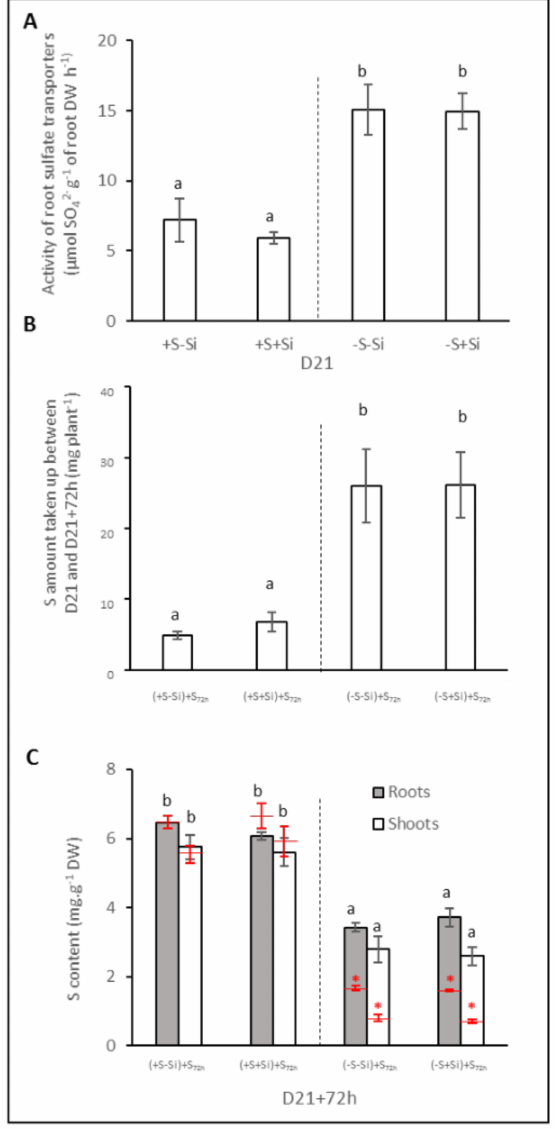
Figure 5. Activity of root sulfate transporters of Brassica napus L. at D21 ( A ), the S amount taken up between D21 and D21 + 72 h ( B ), and the S content in the root and shoot compartments of plants at D21 + 72 h ( C ). Plants were previously cultivated in hydroponic conditions for 21 days with (+S; 500 µ M) or without sulfur (–S; 0 µ M) concentrations and with (+Si; 1.7 mM) or without Si (–Si) supply and then were resupplied with S for 72 h (+S 72h ; 500 µ M). Data are means ± SE (n = 4). Different lowercase letters indicate that the means are significantly different ( p < 0.05). ( C ) for each treatment, red marks indicate the mean ( ± SE n = 4) of S content in the plant compartments at 21 days. For each treatment, the red asterisk indicates significant differences ( p < 0.05) between the S amounts at D21 and at D21 + 72